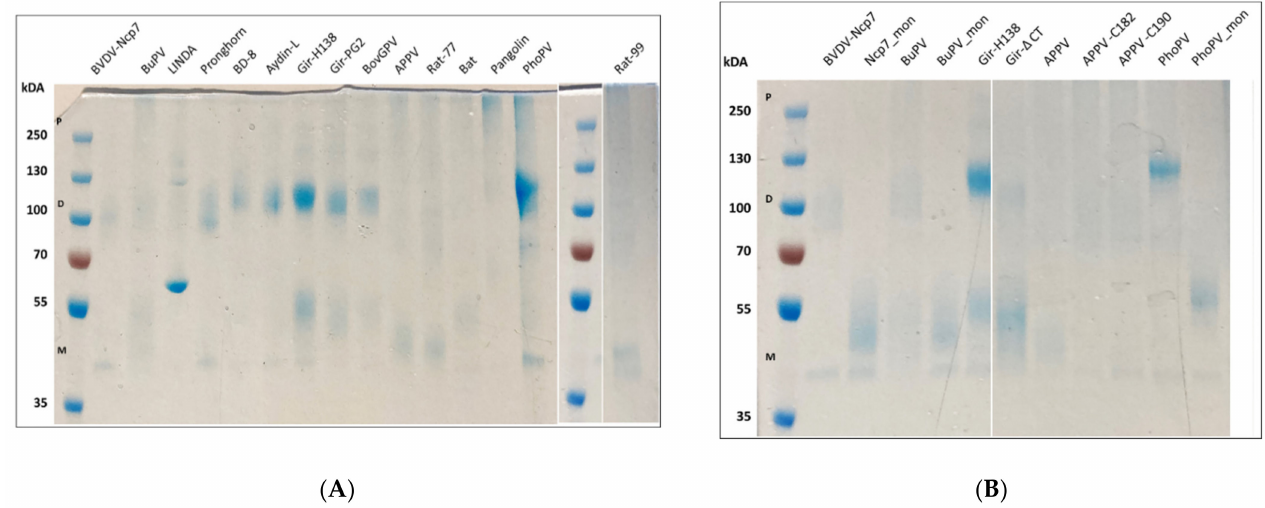
Figure 2. Coomassie staining of the various E rns proteins analyzed. ( A ) Profile of the wild-type (wt) proteins. The absence of a cysteine in a position analogous to BVDV-Ncp7-171 is reflected in the absence of dimer formation (APPV-, Rat-77-, Rat-99-, and Bat-pestiviruses). ( B ) Profile of wt and mutant E rns proteins. Mutant proteins were prevented from dimerization by mutating the corresponding cysteine residue into arginine (Ncp7-mon, BuPV-mon, and PhoPV-mon). The introduction of a ninth cysteine residue on either position 182 or 190 of APPV-E rns did not induce an appreciable dimerization. Next to the pre-stained size ladder, approximate heights of monomers (M), dimers (D), and polymers (P) are indicated. Uncropped gels are available in Supplementary Material Figure